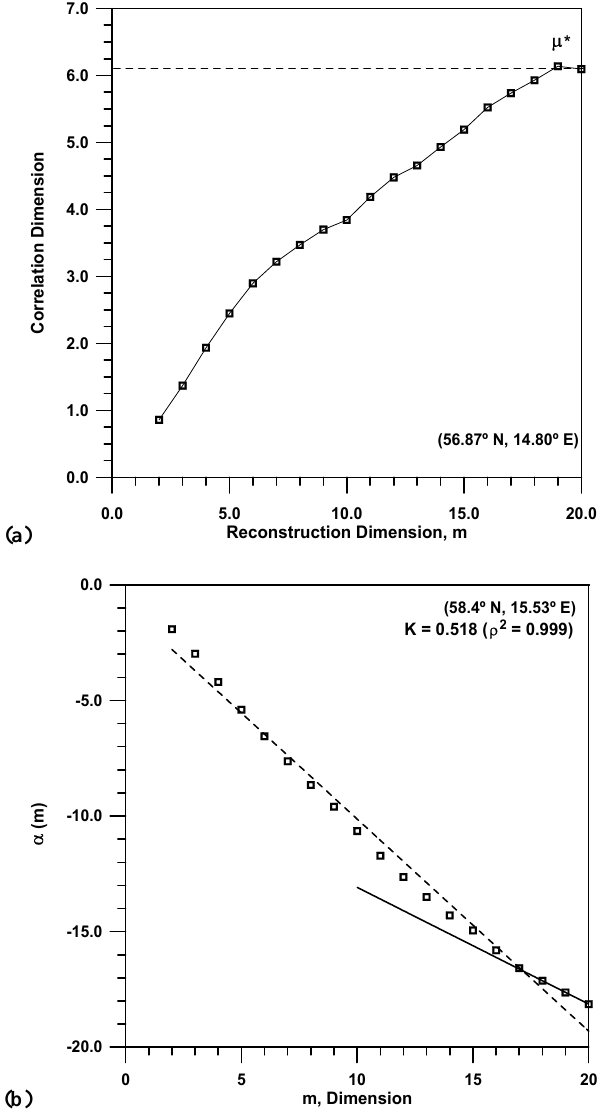
Fig. 8. (a) An example of the evolution of the correlation dimen- sion, µ (m) towards a stationary value, µ ∗ . (b) An example of the right (solid line) and wrong (dashed line) computation of the Kol- mogorov